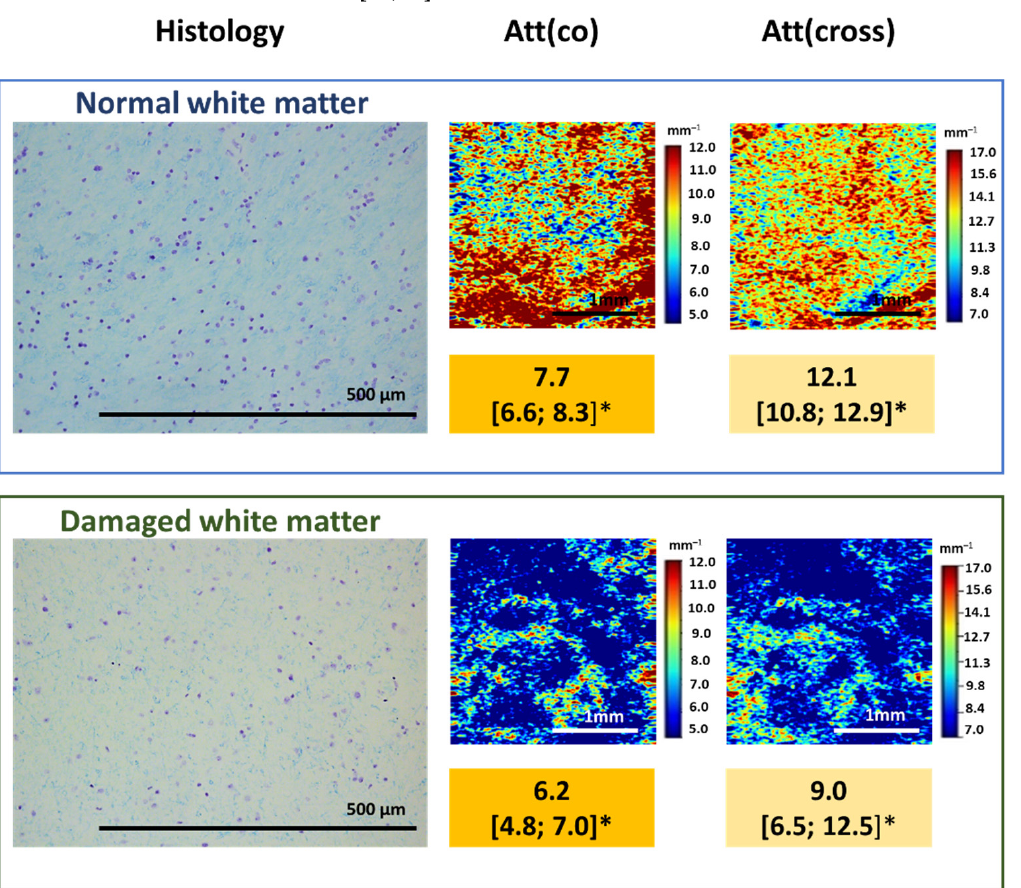
Figure 5. Damage to myelinated fibers in the region of interest causes the decrease in attenuation coefficient values both in co- (Att(co)) and cross-polarizations (Att(cross)), which is reflected on color-coded optical maps—the bright colors (red, orange) of myelinated fibers change to pale blue of damaged myelin. * Me [Q1; Q3]–Me–median value; Q1 and Q3 are the values of the 25th and 75th percentile of the distribution.